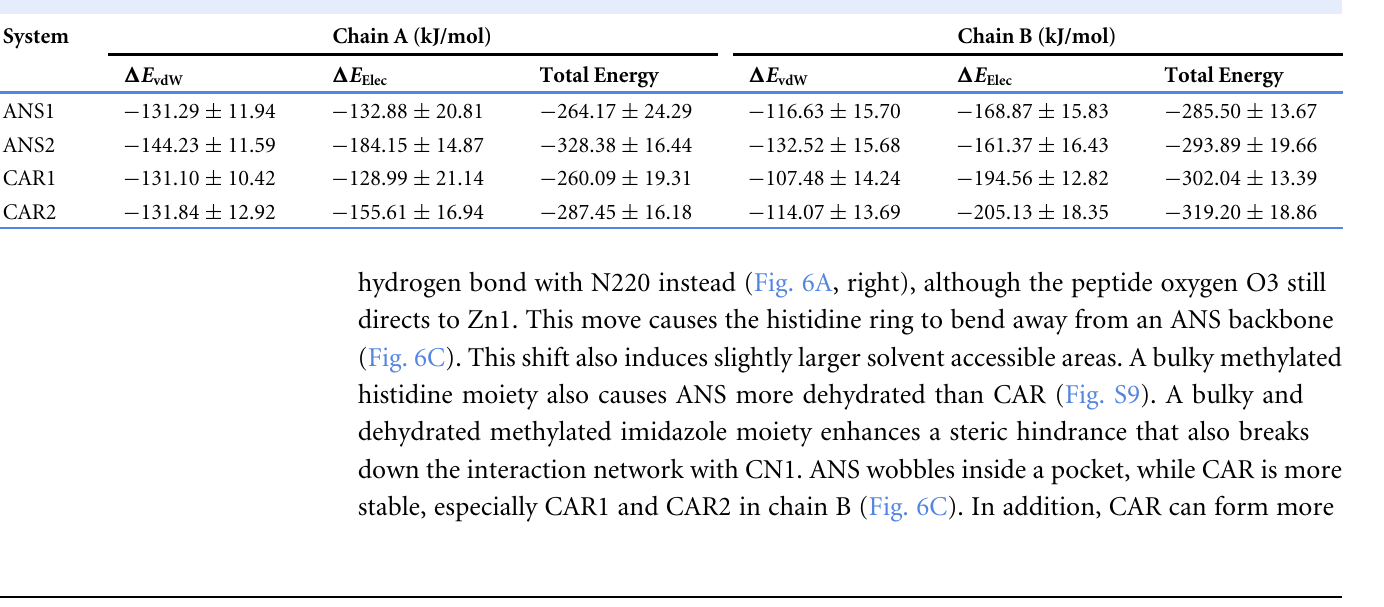
Table 2 Interaction energies (kJ/mol) with standard deviation between a ligand (ANS/CAR) and Zn 2 + -bound CN1 in all systems. The data after 350 ns were used to calculate the interaction